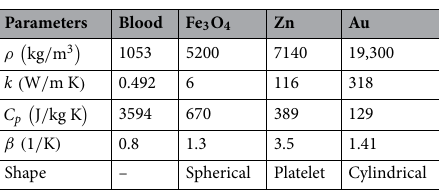
Table 1. Heat characteristics of the base fluid and nanoparticles 55–58 .